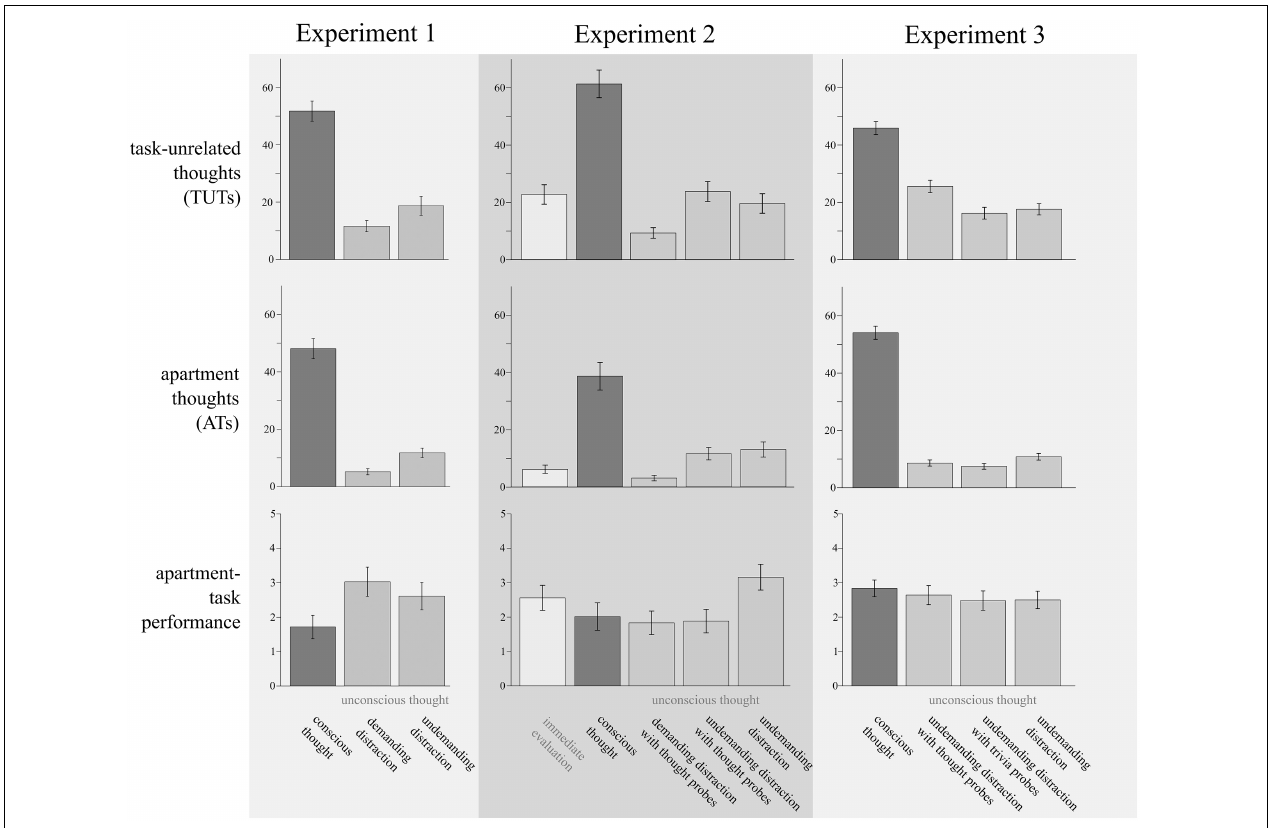
FIGURE 2 | Descriptive data for the main analyses. Columns represent the respective experiment, rows the respective variable. The bars’ colors stand for the thought-mode manipulations employed, with darker gray representing conscious-thought manipulations and lighter gray unconscious-thought manipulations. The immediate-evaluation condition of Experiment 2 is displayed in white. Patterns of results are explained and discussed within the running text. Error bars represent standard errors of the